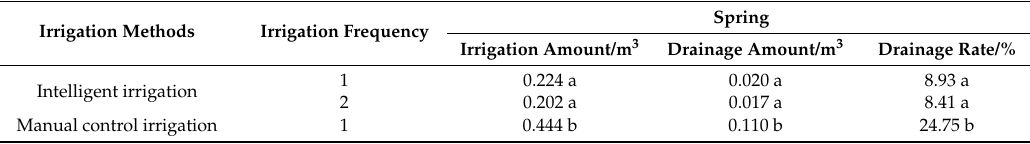
Table 4. Detail comparisons of drainage rate at different irrigation control treatments for 3 days.